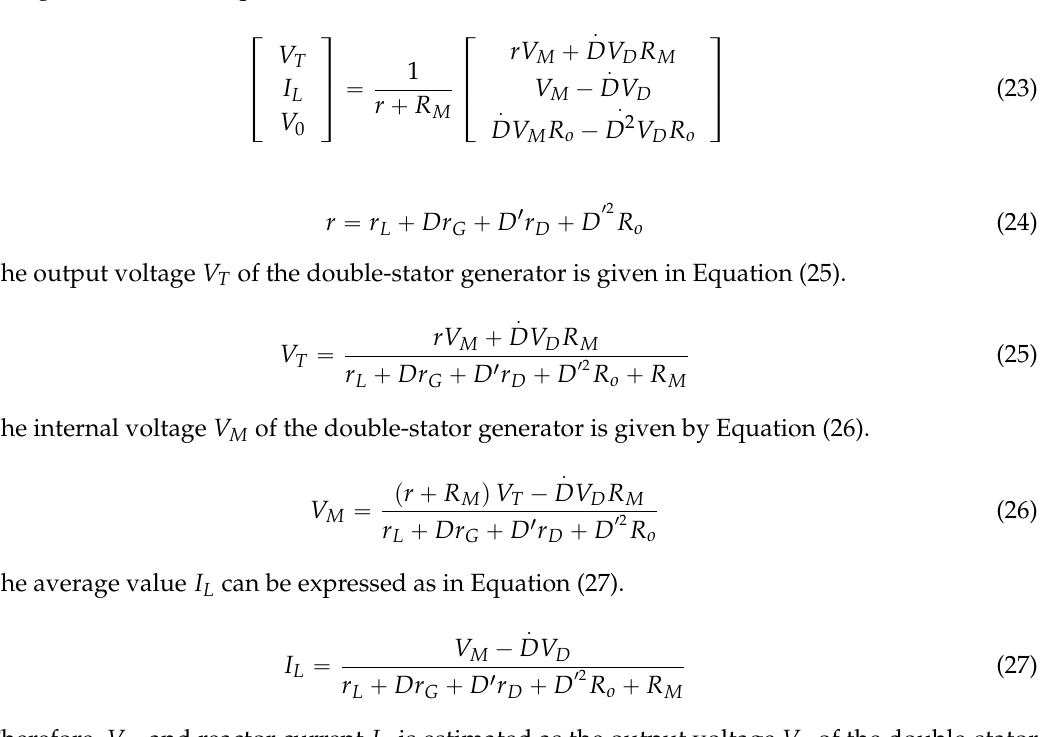
(29) Figure 9. Configuration of the system using a DC/DC boost converter. R M : machine resistance; PI: proportional ‐ integral; PWM: pulse width modulation. The system consists of a double ‐ stator generator, a DC/DC boost converter, an MCU (microcontroller unit), and a load resistance (cid:1844) (cid:2868) , as shown in Figure 10. Primarily the MCU measures the input voltage V T from the voltage sensor. Secondly, it estimates the inductor current (cid:1835) (cid:3013) and the inductive voltage V M , using V T . Finally, the MCU calculates a suitable duty cycle D for the maximum power with each rotational speed and load resistance. This series of events is called the maximum power point estimator control strategy. During the experimental testing of the estimator, the generator is started, and the value of the load resistance is decreased from 100 to 5 Ω to perform the estimator control. Then, the rotation speed is varied from 700 to 1500 rpm to repeat the experimentation further. R M V